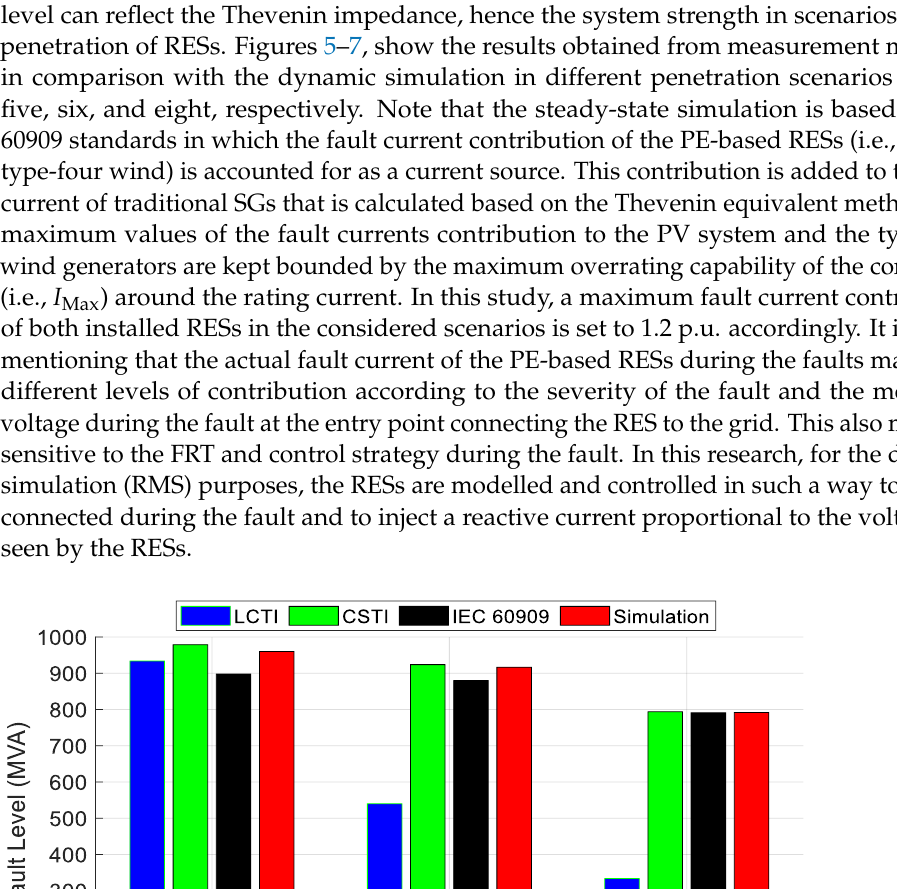
Figure 6. Bus six fault level in different penetration scenarios. Figure 7. Bus eight fault level in different penetration scenarios. Similar to the measurement-based fault calculation methods (i.e., LCTI and CSTI), both steady-state and dynamic simulations have shown the declining trends of the fault